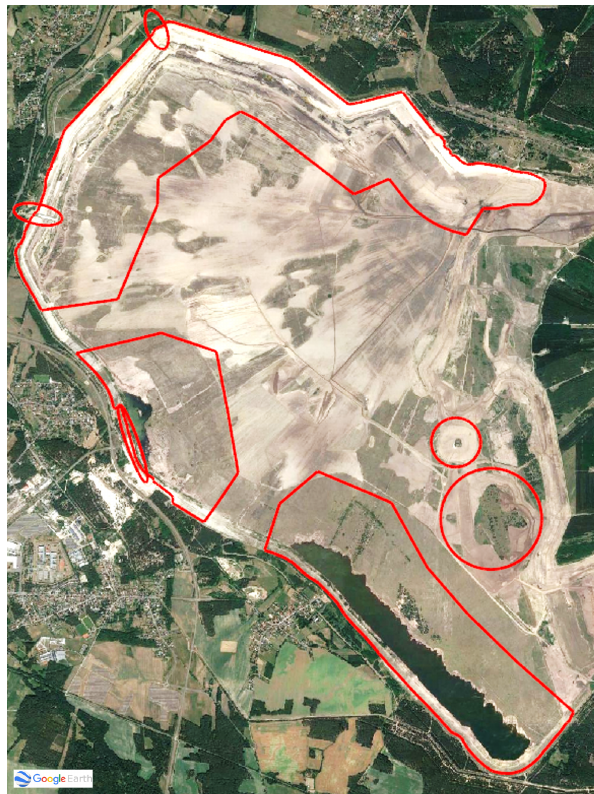
Figure 2. Open-pit test mine (7 . 5km × 5 . 5km) located at (14 ◦ 25 (cid:48) 21 . 14 (cid:48)(cid:48) E, 51 ◦ 47 (cid:48) 1 . 56 (cid:48)(cid:48) N) and owned by LEAG, Cottbus, Germany. Red enclosed area, priority area. Background image cap- tured from © Google Earth.